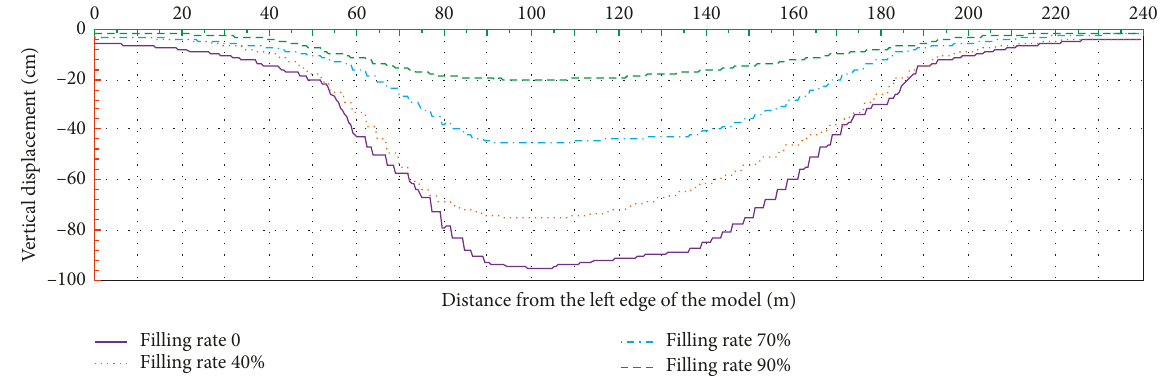
Figure 5: Vertical displacement curves vary with different filling rates.